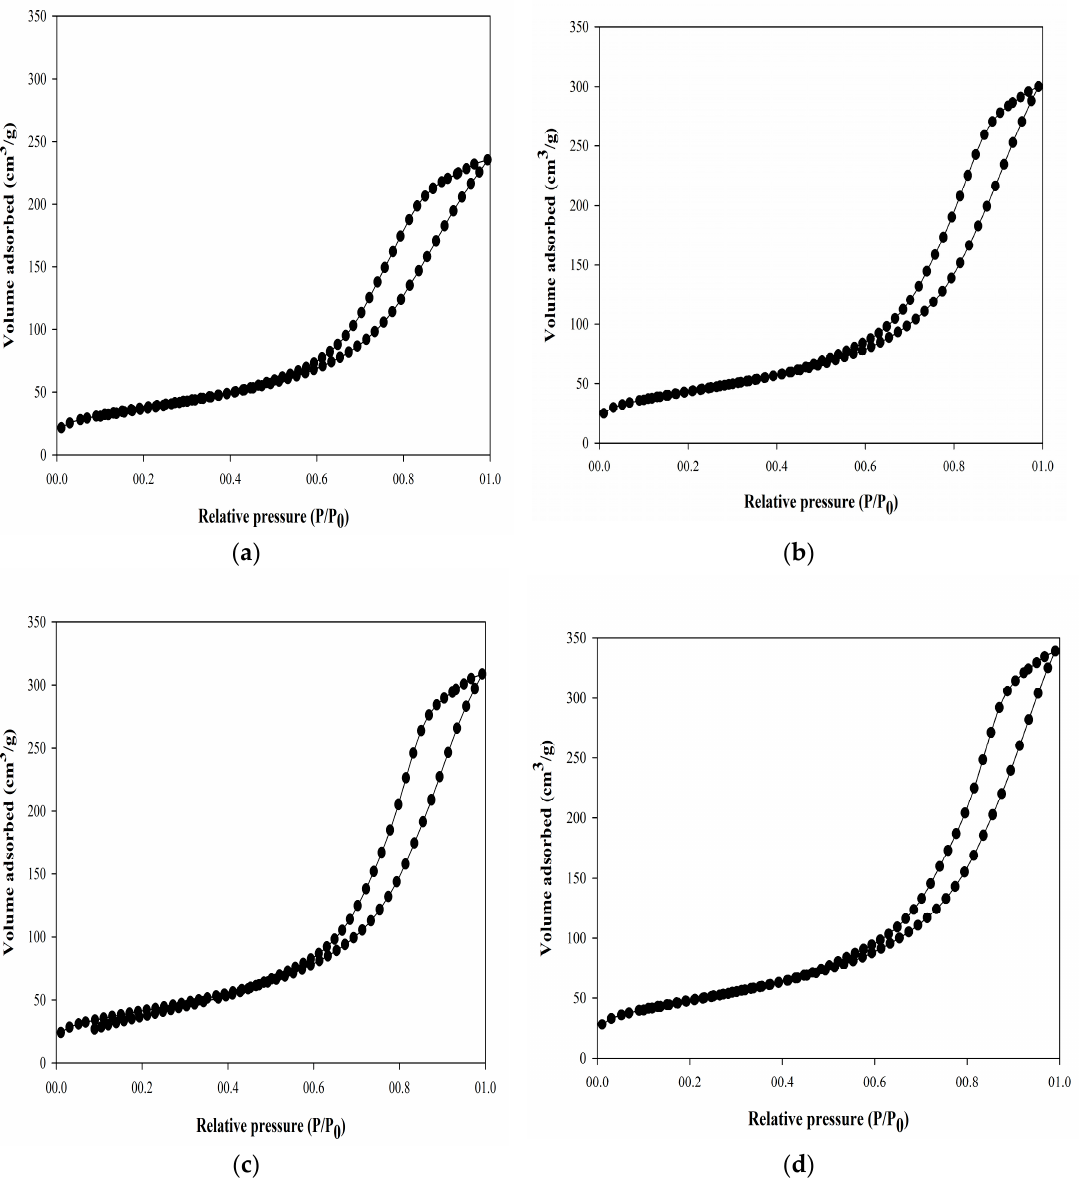
Figure 1. Curves of volume adsorbed (cm3/g) as a function of relative pressure (P/P0) for nitrogen sorption isotherms for mesoporous of ( a ) Pd cat, ( b ) PF1, ( c ) PF2, and ( d ) PF3 catalysts.